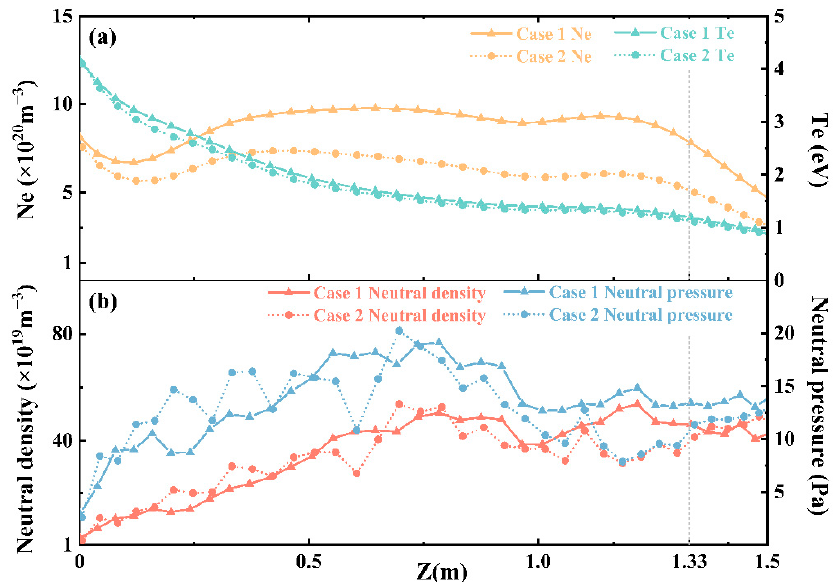
Figure 17. The axial distributions of plasma ( a ) and neutral parameters ( b ) in the two cases. The target position parameters are taken from those in Z = 1.33 m.